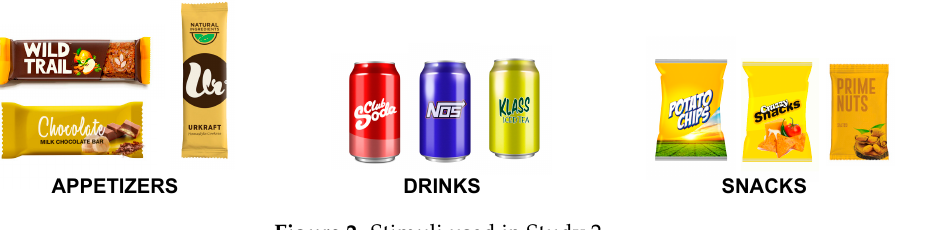
Figure 2. Stimuli used in Study 2.